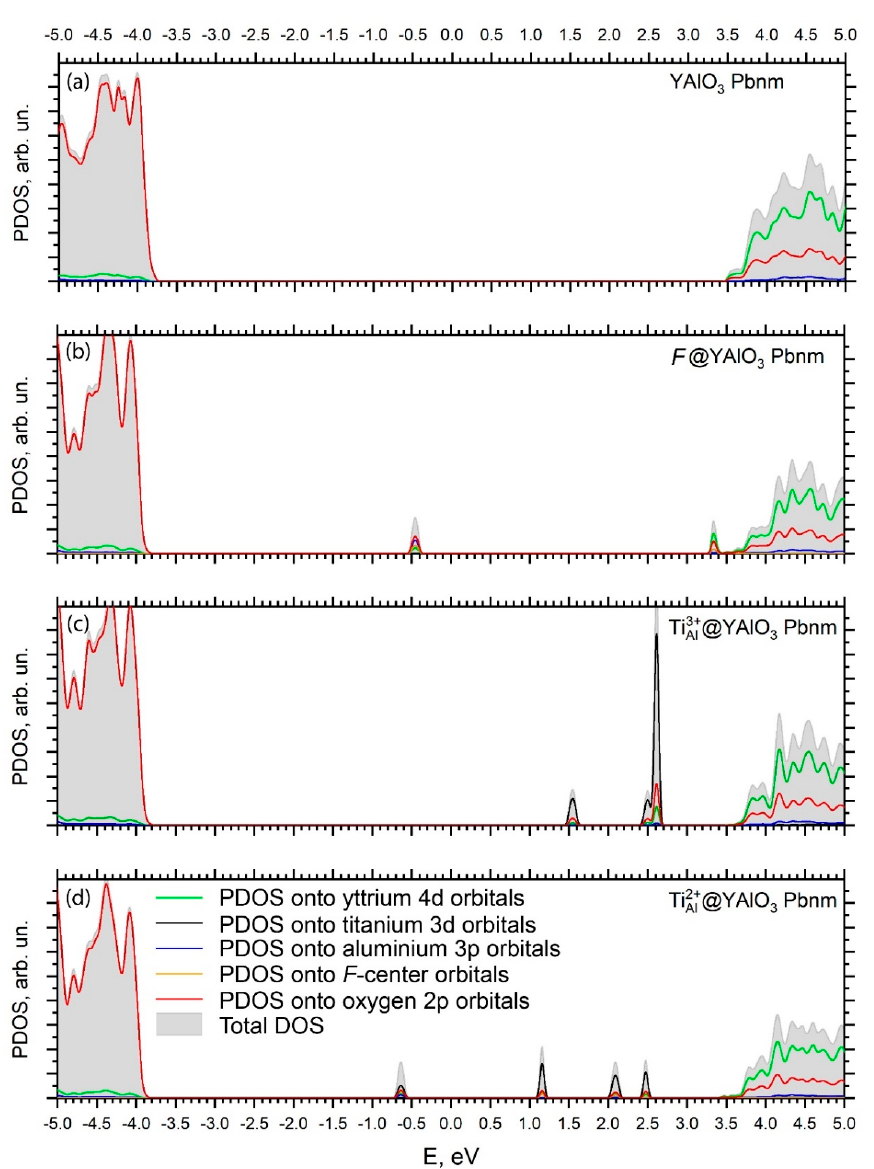
Figure 4. Equilibrium positions of oxygen octahedra in the 2 × 2 × 2 supercell structure of or- thorhombic Pbnm YAlO 3 . ( a ) pristine YAlO 3 , ( b ) YAlO 3 with F -center, ( c ) YAlO 3 containing Ti 3+ ion and ( d ) YAlO 3 containing Ti 2+ ion substituted for host Al 3+ ion. See Table 3 for bond lengths and